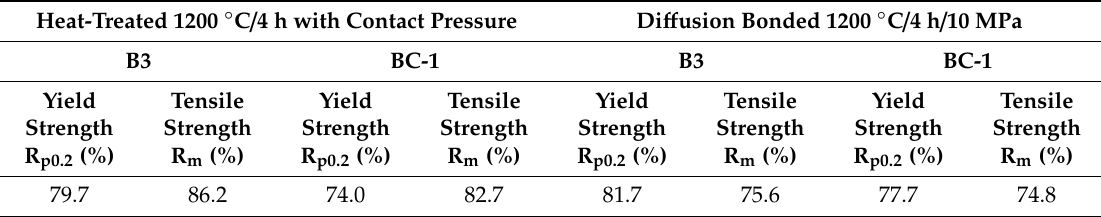
Table 8. Decrease of strength properties of Hastelloy B3 and BC-1 related to delivery